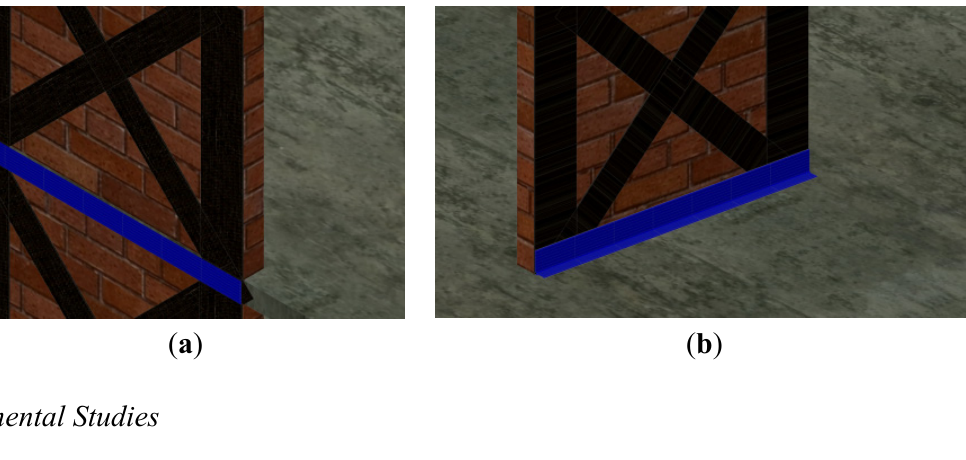
Figure 6. Implementation of mechanical anchorage ( a ) for exterior walls and ( b ) for interior walls.